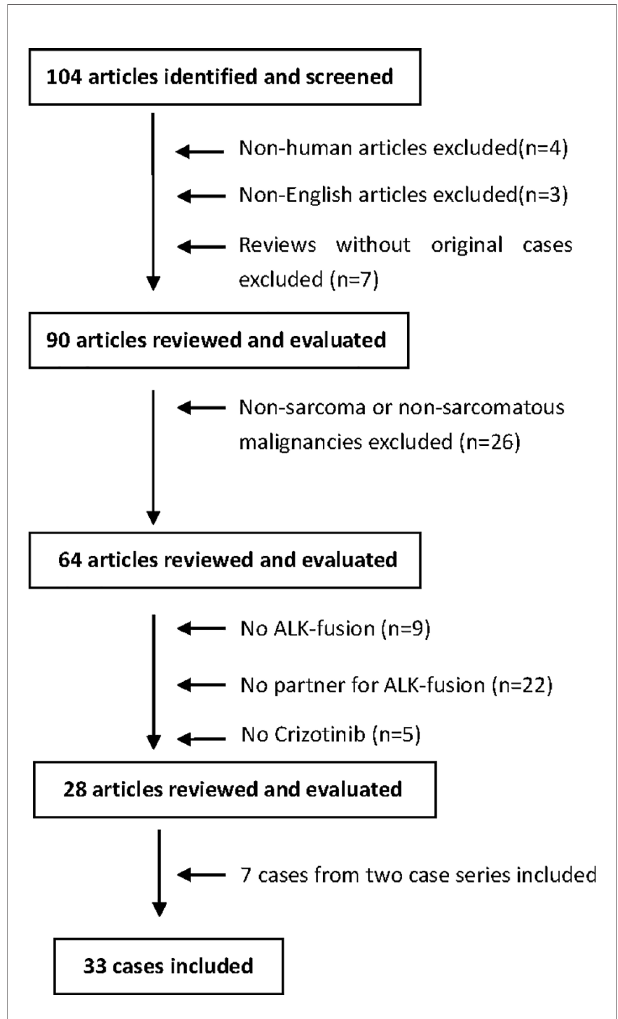
FIGURE 1 | Flow chart of the literature screening in this